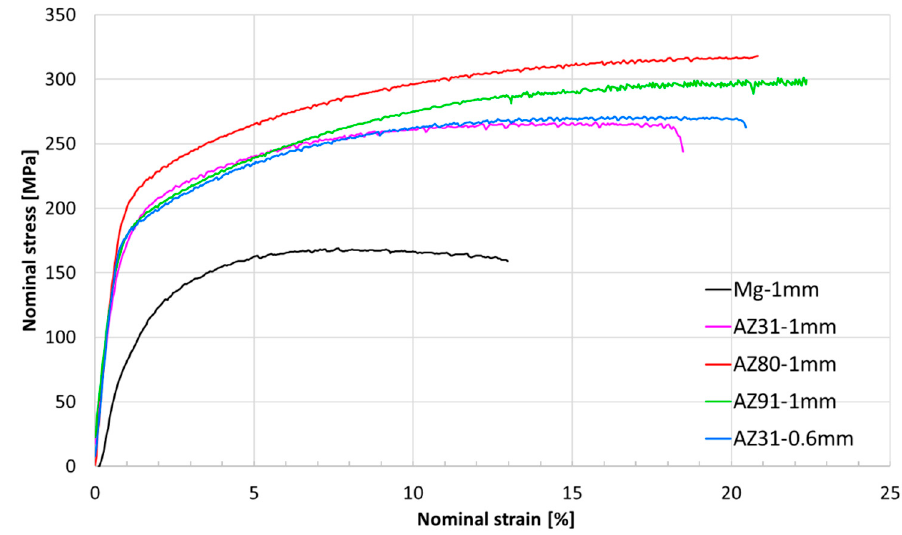
Figure 4. Stress-strain diagram in ED from the extruded 1 mm and 0.6 mm wires.